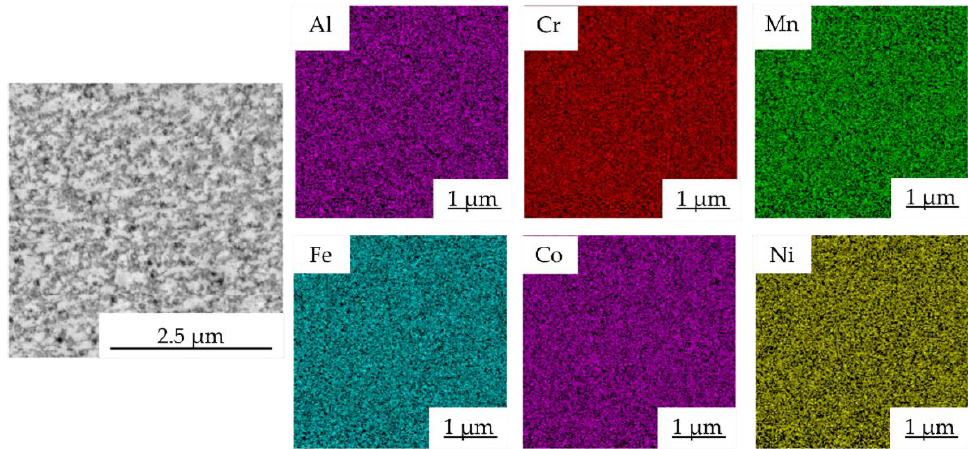
Figure 5. SEM + EDS map of element distribution in Mn10Al10 MA powder alloy.